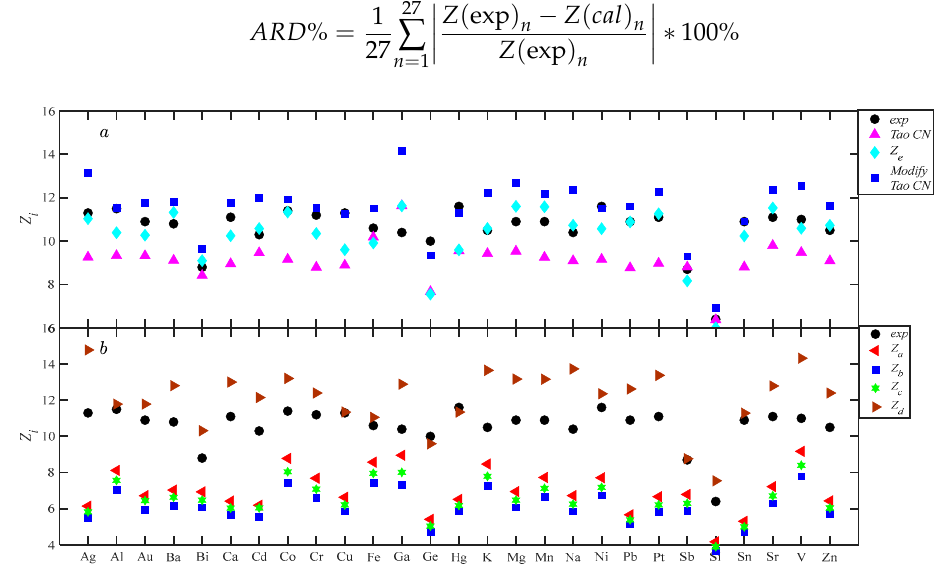
Figure 9. The coordination numbers of 27 liquid metals calculated by different methods. Table 2. The 27 coordination numbers of liquid metals calculated by 7 equations.